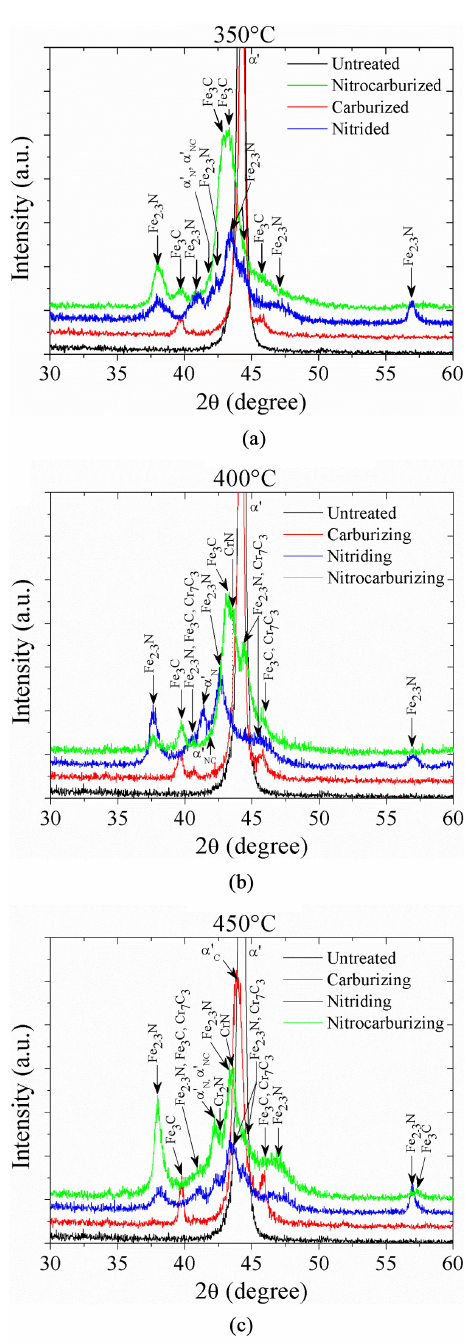
Figure 2. XRD patterns of the treated samples treated at: (a) 350; (b) 400 and (c) 450